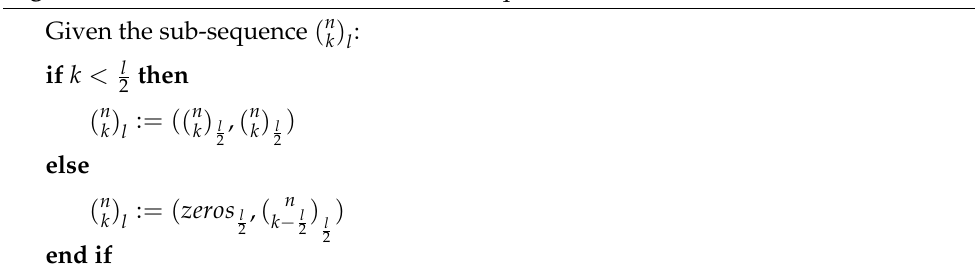
Algorithm 2 Classification of the binomial